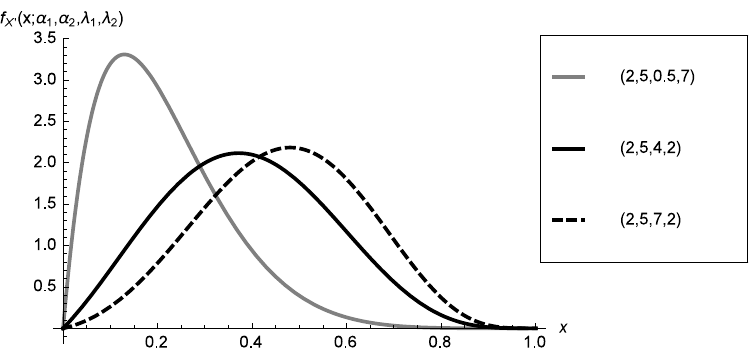
Figure 3 { Plots of the density of X ′ (cid:24) DNCB ( (cid:11) 1 ; (cid:11) 2 ; (cid:21) 1 ; (cid:21) 2 ) for selected values of ( (cid:11) 1 ; (cid:11) 2 ; (cid:21) 1 ; (cid:21) 2 ).